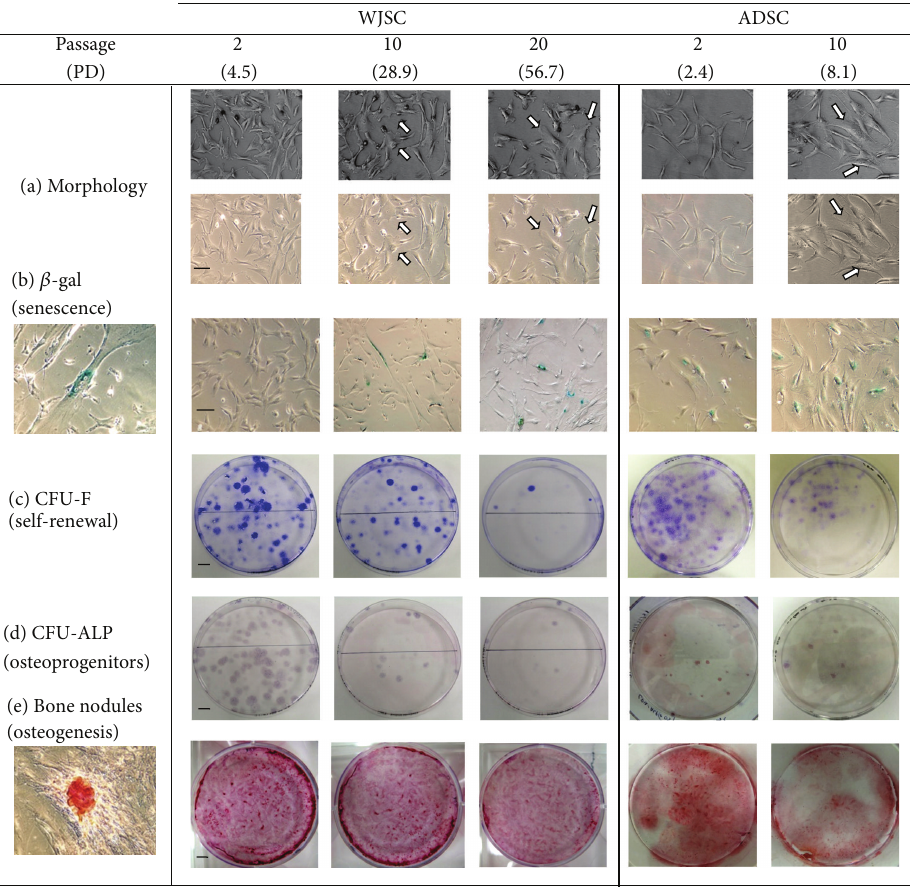
Figure 3: Phenotypic properties of WJSC and ADSC at early and late passages. (a) Light microscopy photos illustrating cell morphology; arrows show cells with type III morphology. Top row, phase contrast. Mag. = 25x. (b) Senescence, as depicted by 𝛽 -gal staining. Mag. = 25x. Subpanel shows a giant cell ( > 650 𝜇 m in length) with typical senescent phenotype. (c) Crystal violet staining of CFU-F (self-renewal capacity). (d) Formation of CFU-ALP (osteoprogenitor colonies). (e) Calcified bone nodule formation in response to osteogenic stimulation. Subpanel illustrates a typical alizarin red-stained bone nodule at high magnification (25x). Scale bars: (a) and (b) 100 𝜇 m, (c) and (d) 10mm, and (e)